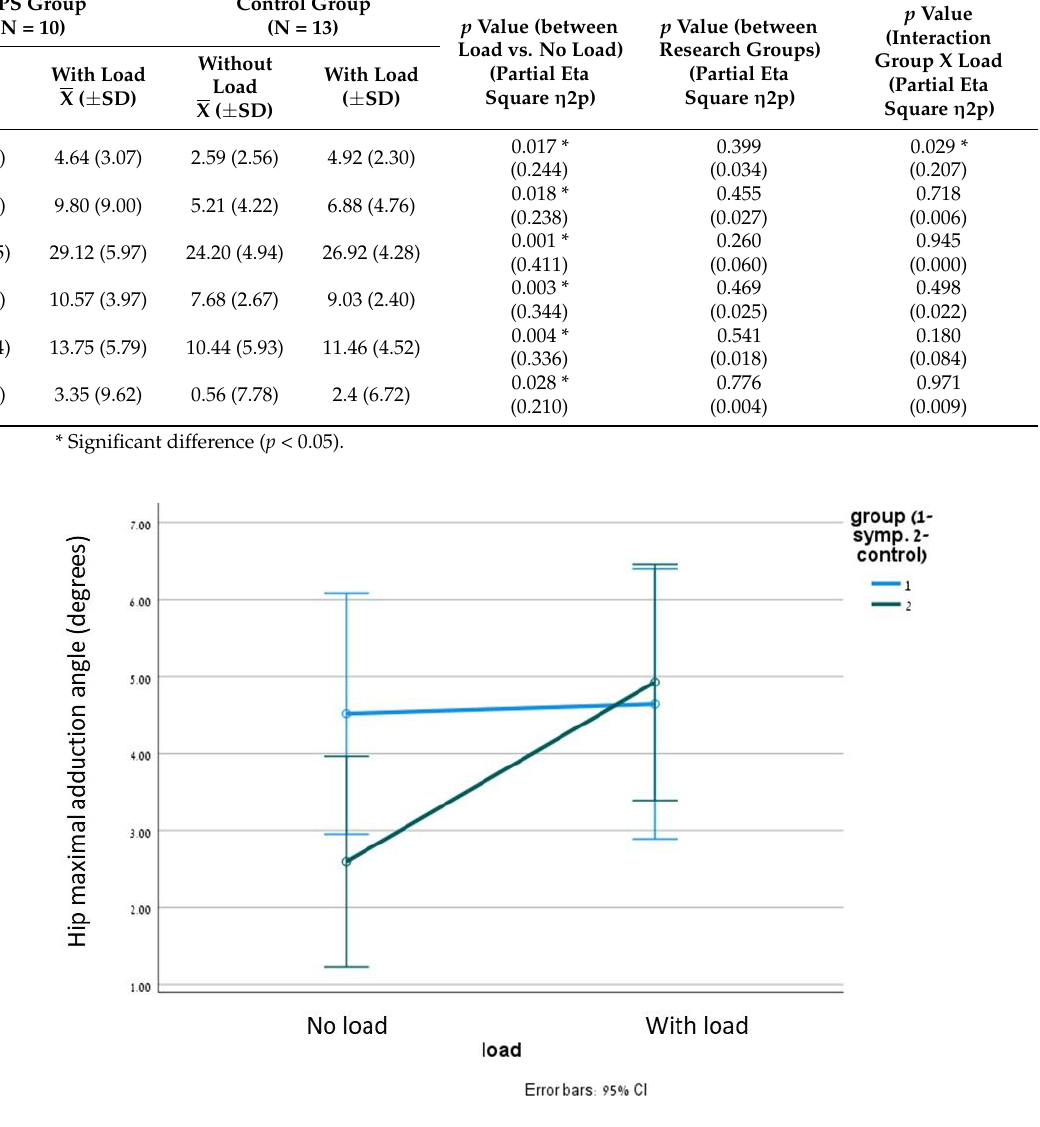
Figure 3. Hip joint adduction maximal angle (in degrees) according to the PFPS, controls and load conditions (right leg).